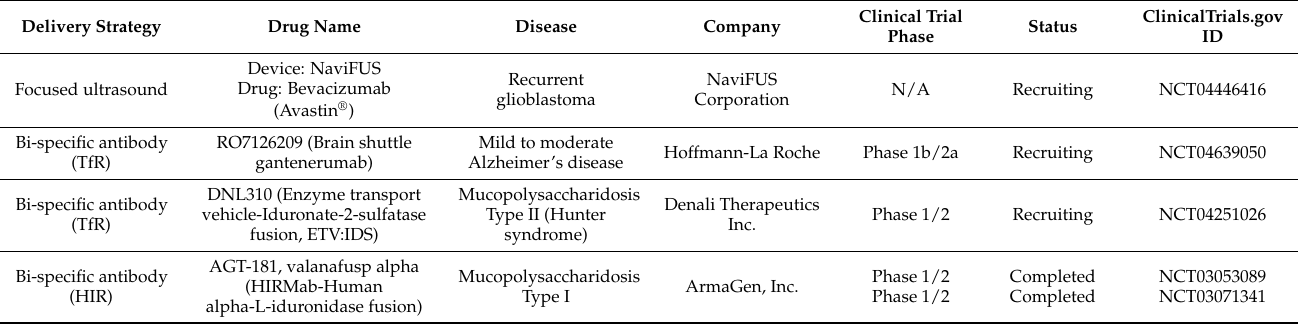
Table 2. Current delivery strategies in clinical